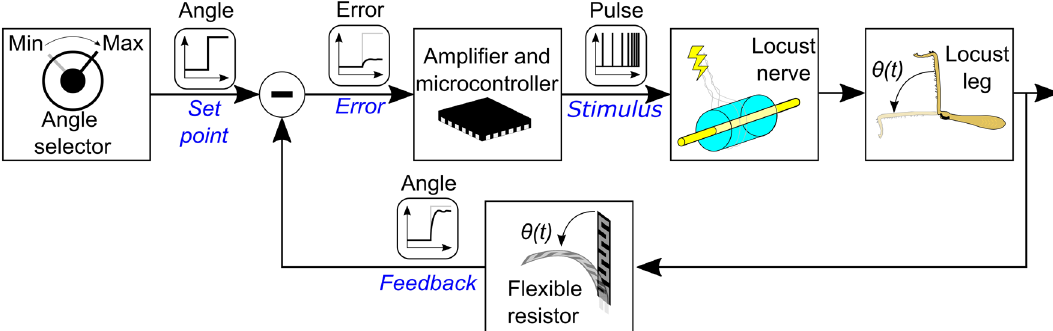
Figure 1. Scheme of the implemented control loop. The angle set point is selected and the measured leg angle subtracted from it to conform the error signal, which is sampled by the microcontroller. A proportional control algorithm runs in the microcontroller, varying the period of the stimulus signal applied on the nerve. The leg angle is sensed with a flexible resistor to provide the